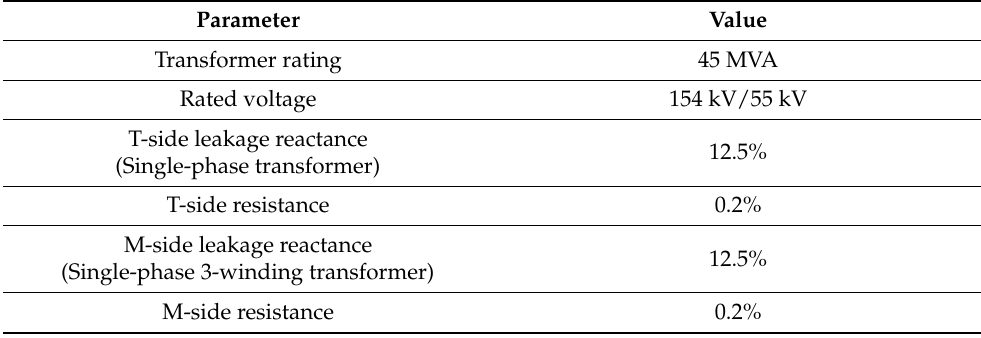
Table 2. Detailed parameters of Scott transformer (identical to those of the transformer certified by KERI).